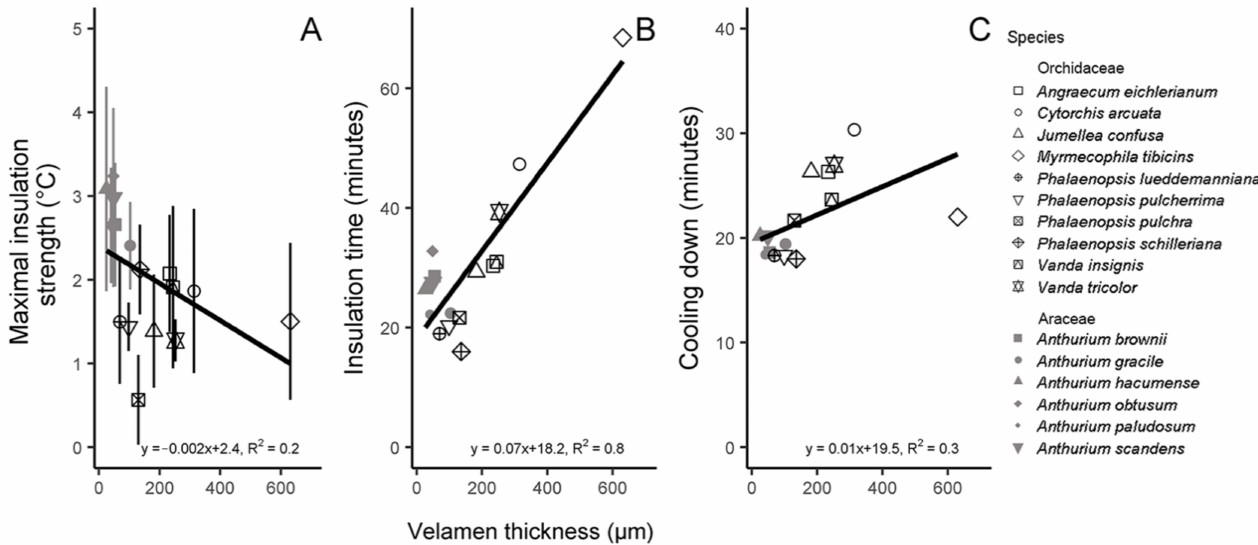
Figure 2. Thermal insulation traits correlated with the velamen thickness of 16 epiphyte species: the maximal insulation strength ( ∆ T max , ( A )), the insulation time ( B ) and the time to cool down ( C ). Species belonged to Orchidaceae (black, open symbols) and Araceae (grey, closed symbols). The equations and coefficients of determination are given for each regression (all p < 0.05). Data are means of three individuals per